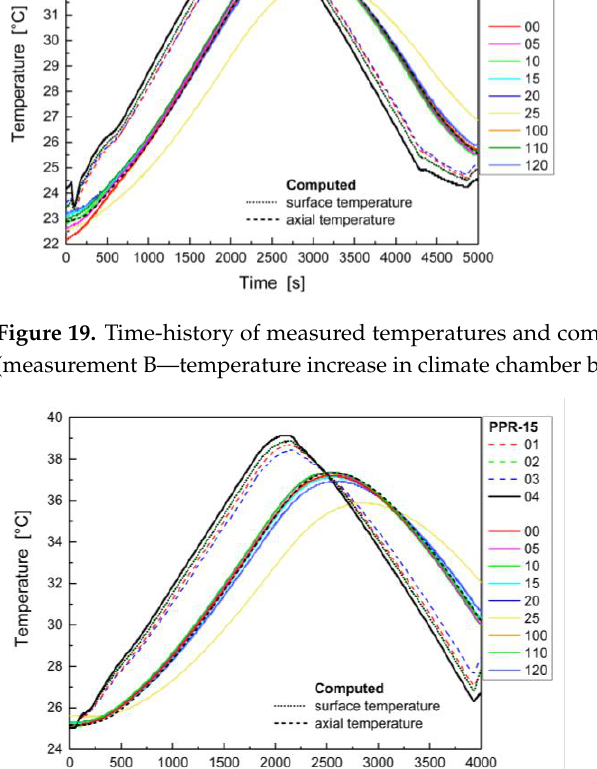
Figure 19. Time-history of measured temperatures and computed surface and axial temperatures (measurement B — temperature increase in climate chamber by 10 °C/probe 1).